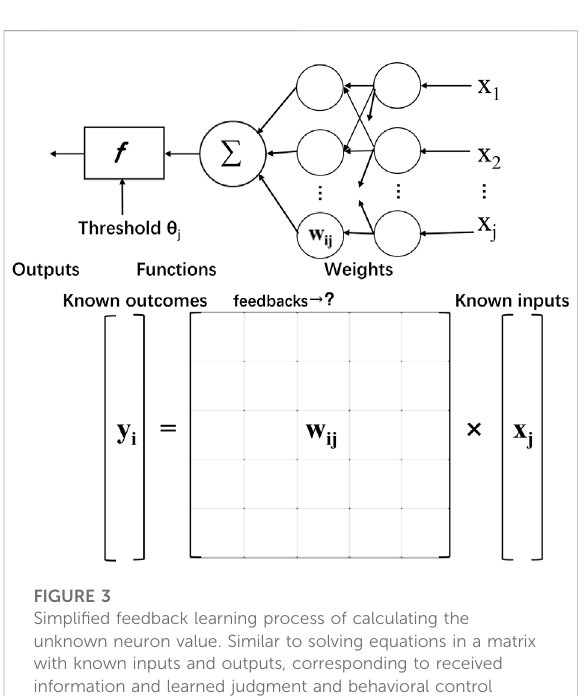
FIGURE 3 Simpli fi ed feedback learning process of calculating the unknown neuron value. Similar to solving equations in a matrix with known inputs and outputs, corresponding to received information and learned judgment and behavioral control information, the neural network derives parameter processing information, that is, weights, through